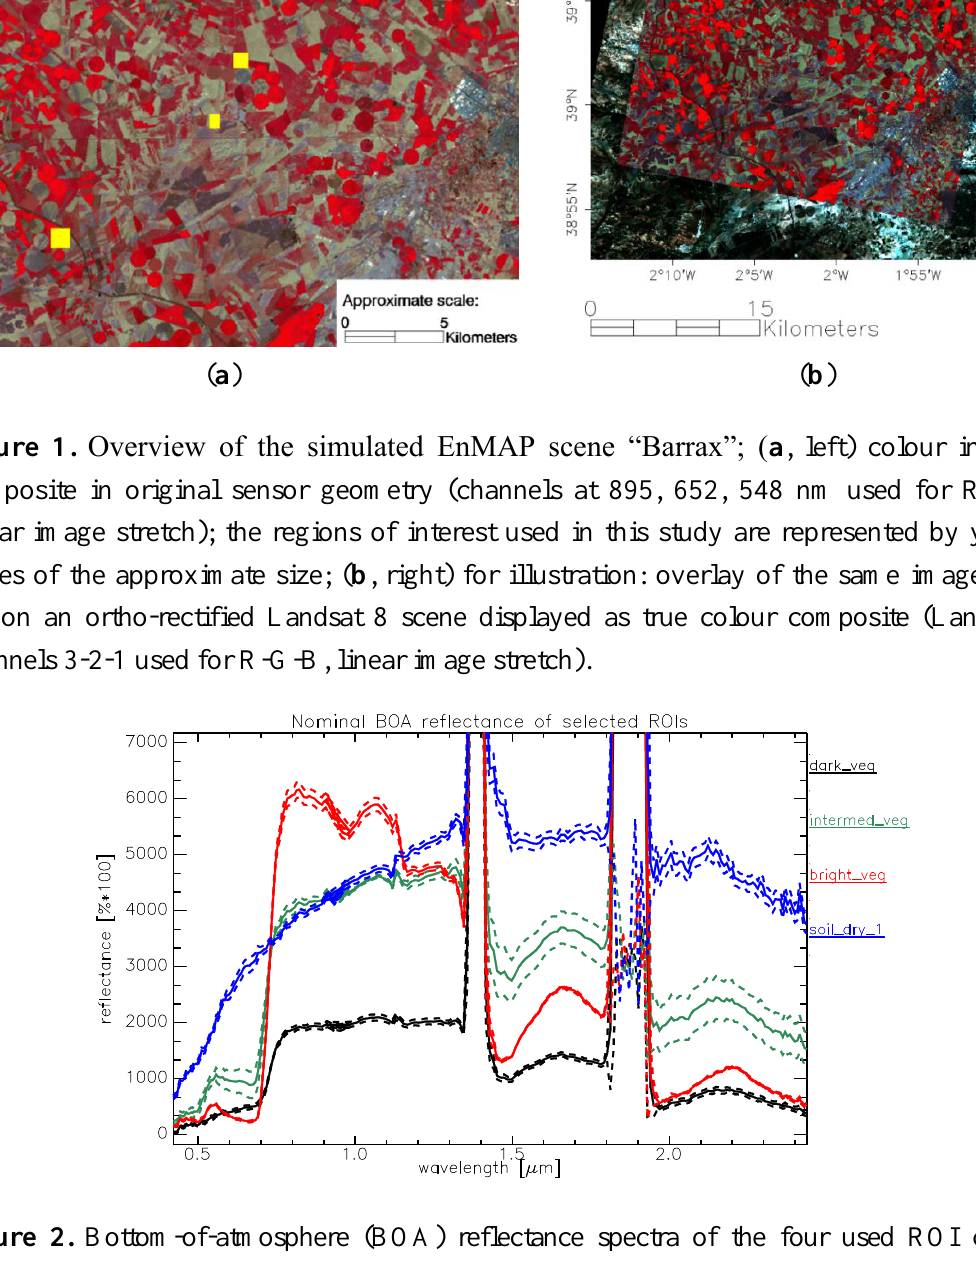
Figure 2. Bottom-of-atmosphere (BOA) reflectance spectra of the four used ROI classes (solid lines) and the related standard deviation (dotted lines). For the vegetation classes, the name prefix “dark”, “intermediate” and “bright” relates to the relative reflectance in the